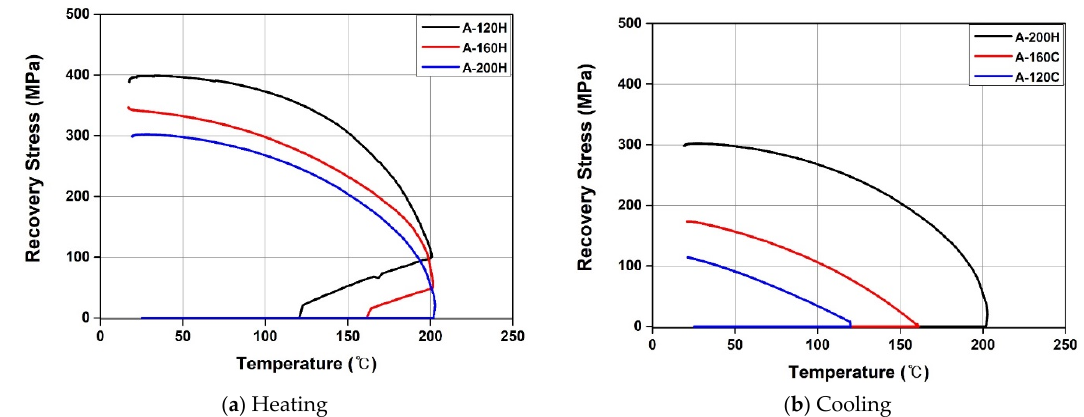
Figure 10. Comparison of FSMA ‐ A’s temperature ‐ recovery stress curves under partial restraint; ( a ) Heating; ( b ) Cooling